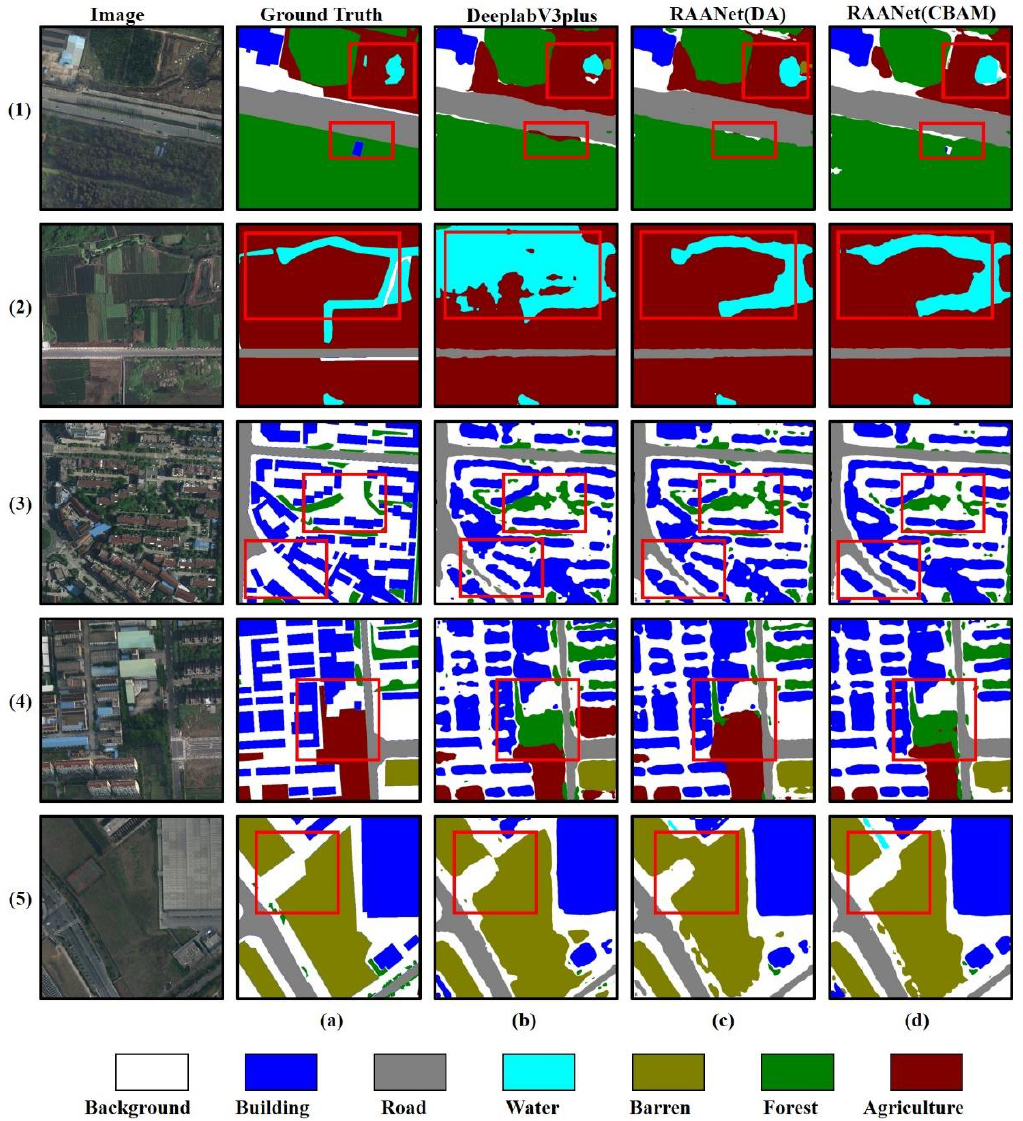
Figure 7. Prediction results of the DeeplabV3plus, RAANet (DA), and RAANet (CBAM). ( 1 – 5 ) represents five random parts of the experimental sample, ( a ) represents the ground truth, ( b ) represents the results of the DeeplabV3plus model, ( c ) represents the results of the RAANet (DA), and ( d ) represents the results of the RAANet (CBAM).